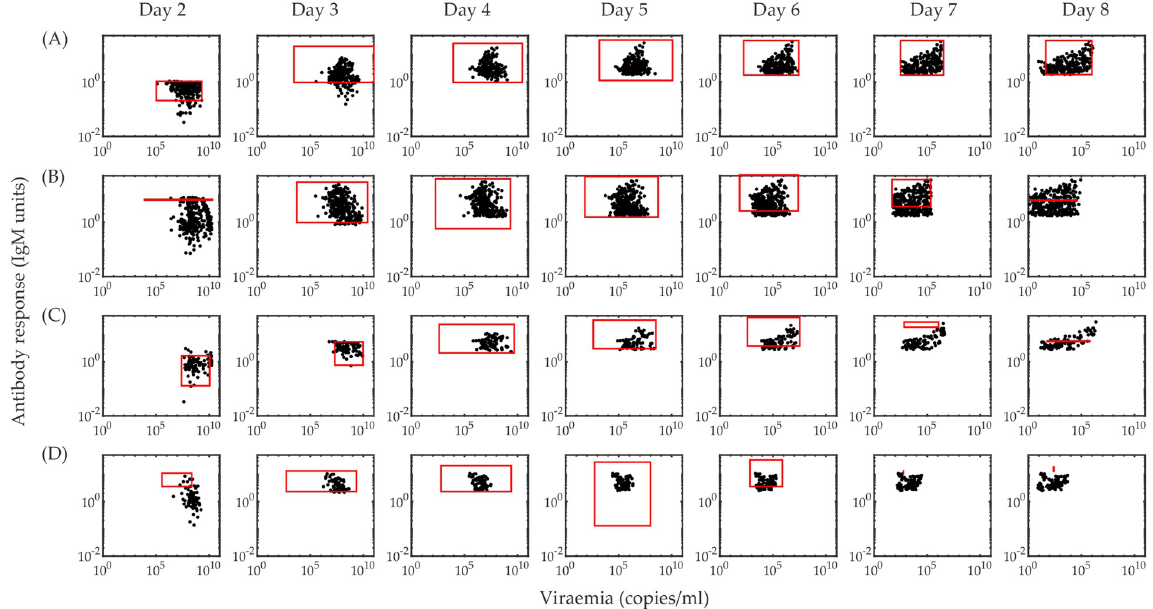
Fig 3. Calibration of the population of models. The scattered plots of antibody response vs. viraemia calculated from the calibrated POMs are shown on each day of illness. Each row represents a serotype as (A) DENV-1, (B)DENV-2, (C) DENV-3 and (D) DENV-4. The red boxes in all plots represent the range of the biomarker levels in the dataset on the particular day of illness. Every scattered plot represents the compact calibration of the models with available bimarker data. We do not show days 1, 9 and 10 as there is no available data for these days. The calibration of DENV-2, DENV-3 and DENV-4 POMs are weakly calibrated on day 2, 7, and 8 due to lack of availability of data. Day 2 and day 8 in the DENV-2 POMs, and day 8 in the DENV-3 POMs do not have any antibody data. In the DENV-4 POMs, day 7 and day 8 have single observations for viraemia and no antibody response data is